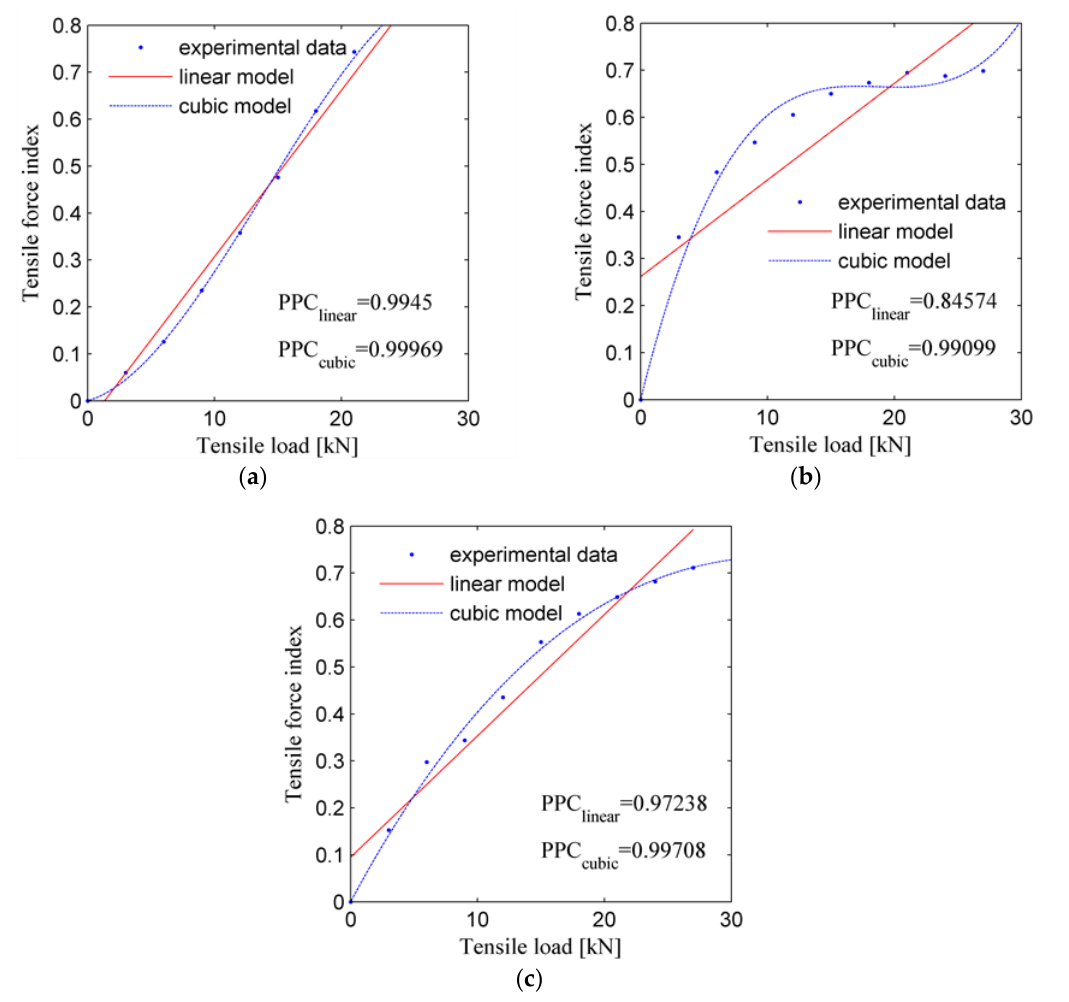
Figure 11. Tensile force index of the three samples during the elastic deformation stage: ( a ) Sample L1; ( b ) Sample L2; ( c ) Sample L3.